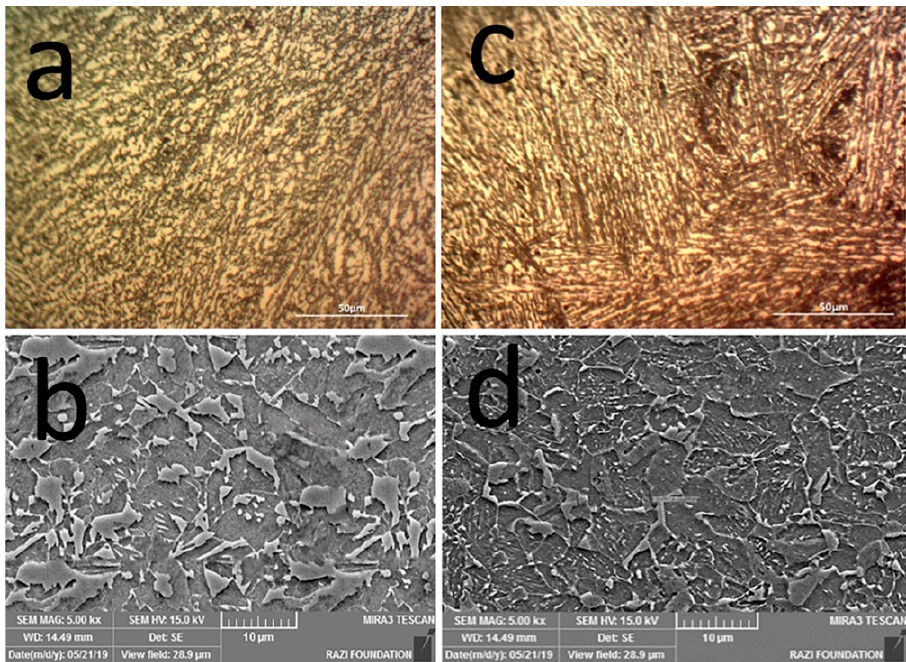
Figure 5. ( a ) Optical microscopy and ( b ) SEM metallography of sample 1.6511Si2V; ( c ) optical microscopy and ( d ) SEM metallography of sample 1.6511Si2M. SEM metallography shows that the microstructure of both alloys is granular bainite. Note: 1.6511Si2V is CFB while 1.6511Si2M is containing carbides.